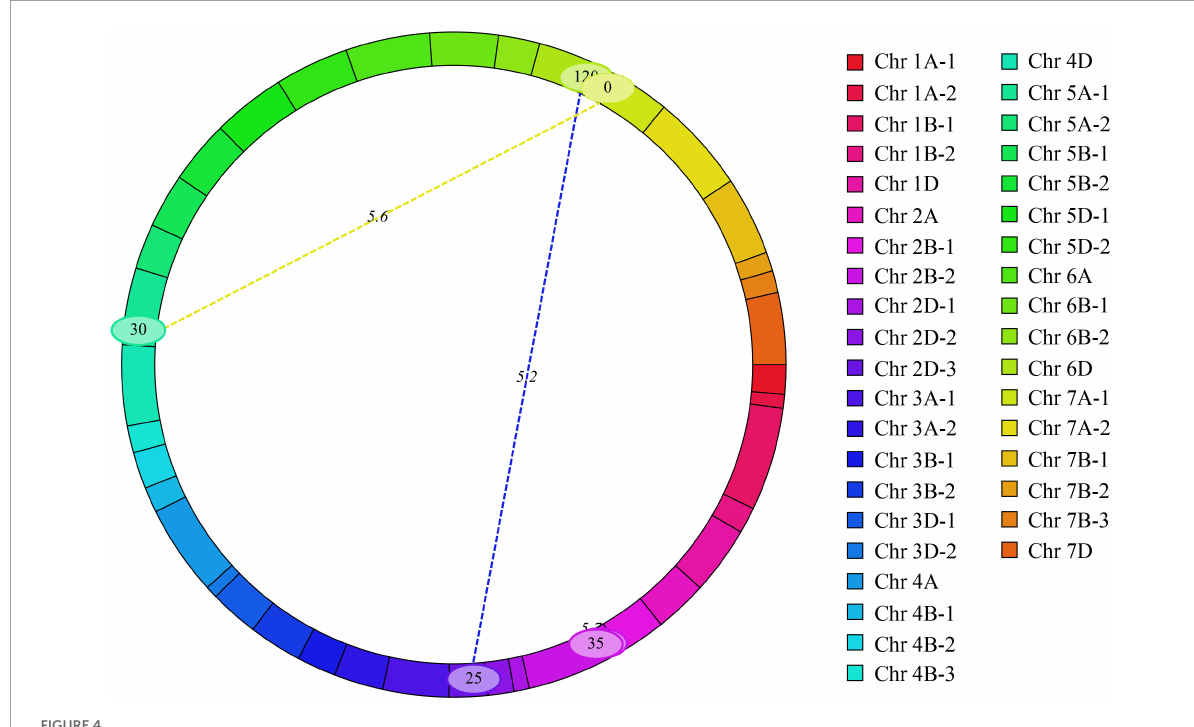
FIGURE4 Epistatic quantitative trait loci (QTL) were detected across 21 chromosomes.